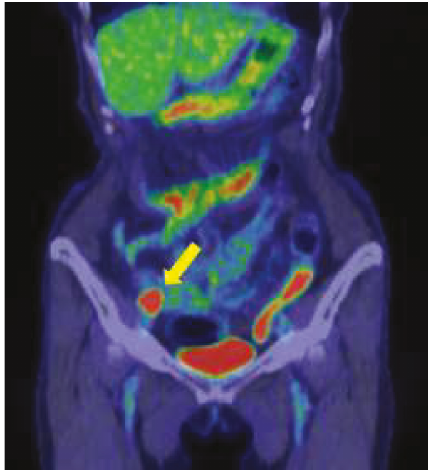
Figure 3: PET-CT showing intense tracer uptake (SUV max: 17.5) at the tumor